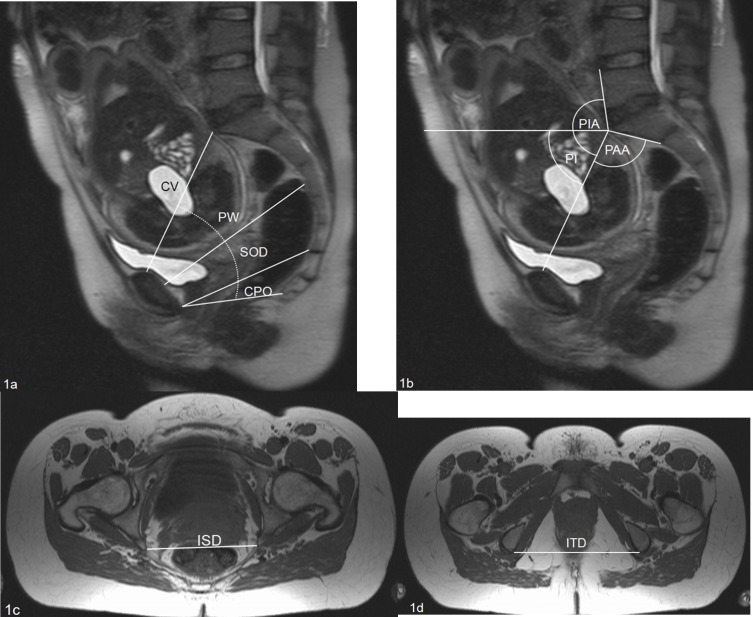
a: Sagittal distances. b: Sagittal angles.18,24. All distances were measured from cortex to cortex. CV = conjugata vera (cm): Sagittal distance between the promontory and the dorsal surface of the symphysis. PW = pelvic width (cm): Sagittal distance between the dorsal surface of the symphysis and the middle of the third sacral vertebra. SOD = sacral outlet diameter (cm): Sagittal distance between the lower margin of the symphysis and the sacral tip. CPO = coccygeal pelvic outlet (cm): Sagittal distance from the coccygeal tip to the lower margin of the symphysis. PAA = pelvic aperture angle (°): Angle between the CV and a line on the ventral surface of the first sacral vertebra. PIA = pelvic inlet angle (°): Angle between the CV and a line on the ventral surface of the caudal lumbar vertebra. PI = pelvic inclination (°): Angle between the CV and a horizontal line. Fig 1c+1d: Axial diameters.18,24. ISD = interspinous diameter (cm): Distance between the endpoints of the ischiadic spines. ITD = intertuberous diameter (cm): Distance between the posterior edges of both tubera ischii.